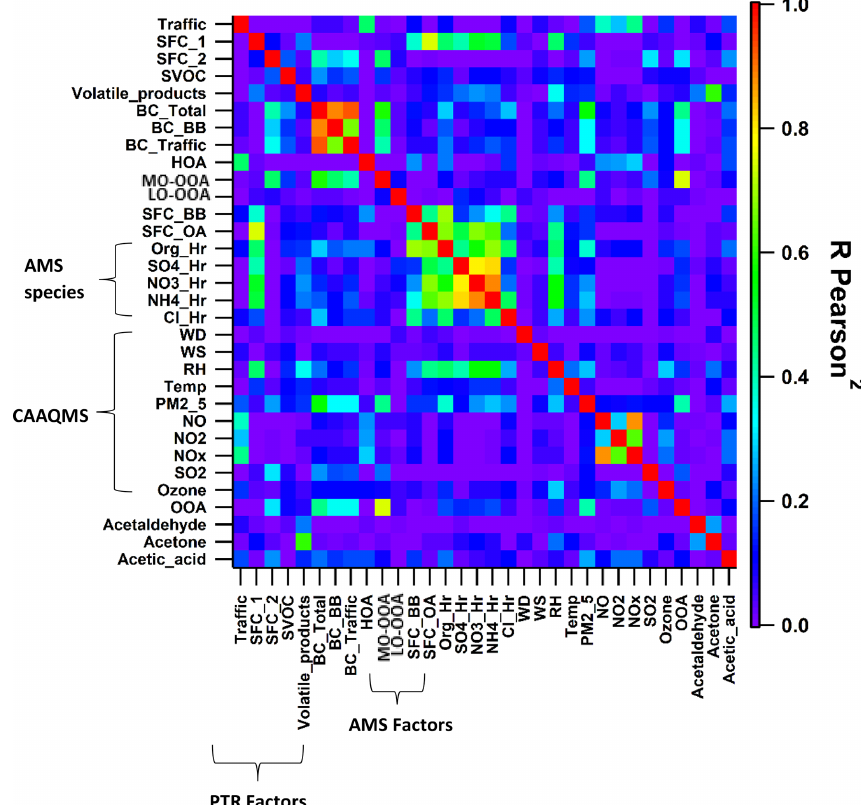
Figure 6. Correlation of the five factors in the external measurements, including factors from AMS, organic NR-PM 2 . 5 and inorganic NR–PM 2 . 5 , black carbon (BC total, percentage BC from fossil and non-fossil fuels), CAAQMS data, total oxygenated organic aerosols (OAAs), and VOC species. The CAAQMS data include wind direction (WD), wind speed (WS), relative humidity (RH), ambient temperature (temp), particulate matter (PM 2 . 5 ), nitric oxide (NO), nitrogen dioxide (NO 2 ), nitrogen oxides (NO x ), sulfur dioxide (SO 2 ), and ozone. The correlation between the time series of the parameters is represented by R Pearson 2 , colour-coded with a rainbow colour scheme, showing violet as 0 (no correlation) and red as 1 (highest